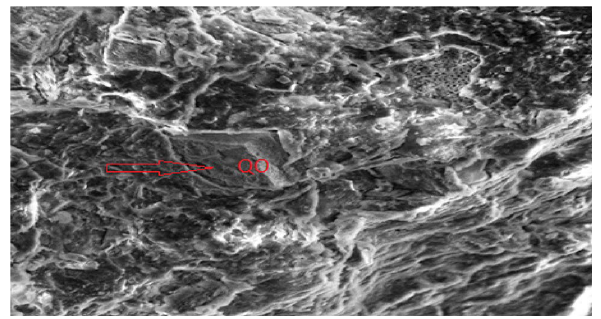
Fig. 17 Quartz overgrowth in Ayede Ajegunle at a depth range of 63–66 m. QO quartz overgrowth. Magnification = ×100